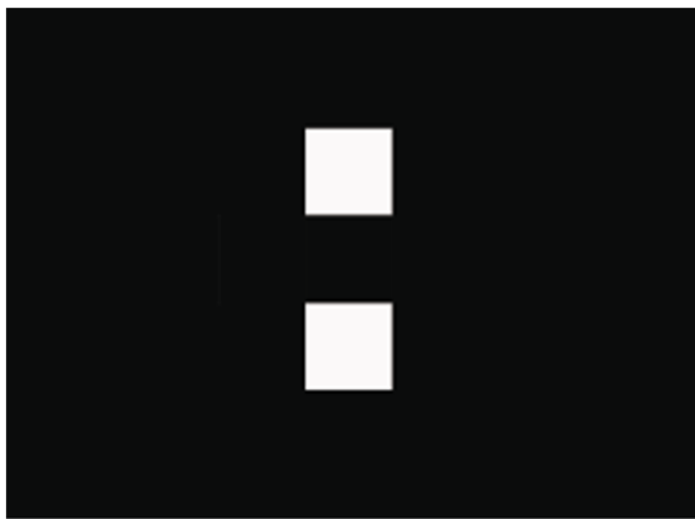
Figure 4. Ernest Edmonds, still from Fragment (1964–65).